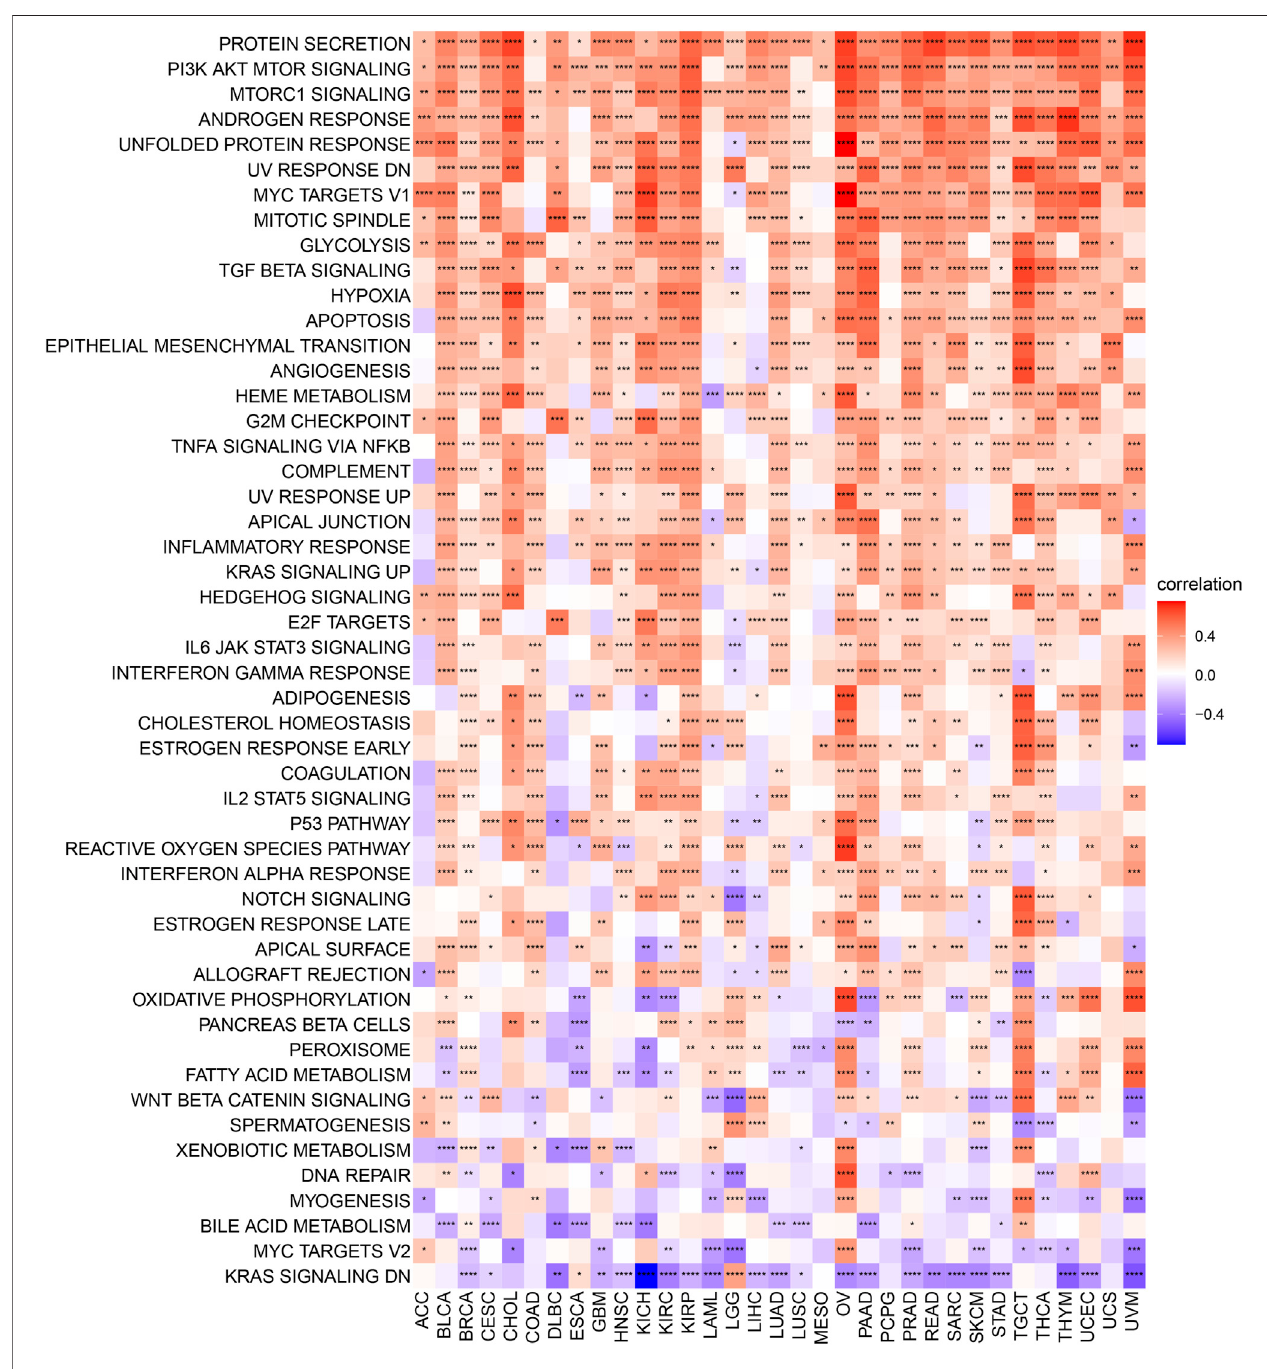
FIGURE 7 | GSVA of AP3S1 in TCGA pan-cancer. GSVA results of 50 hallmark pathways from the MSigDB.